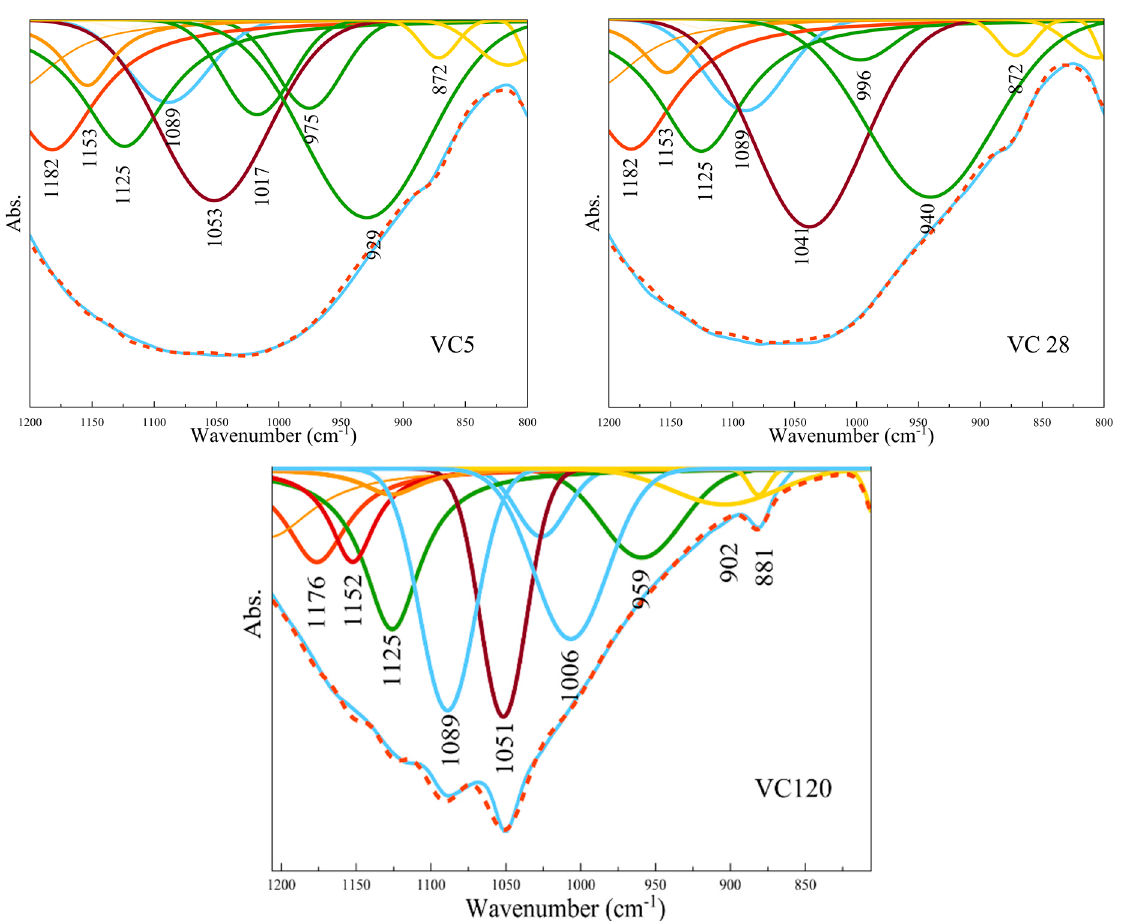
Figure 2. Deconvolution of Si–O asymmetric stretching band obtained by FTIR analysis. (Abs.: